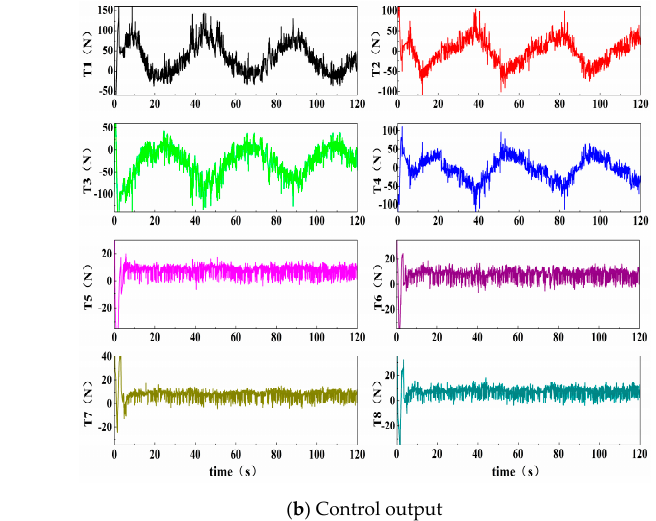
Figure 3. The control effect of the compared method under Case 1.